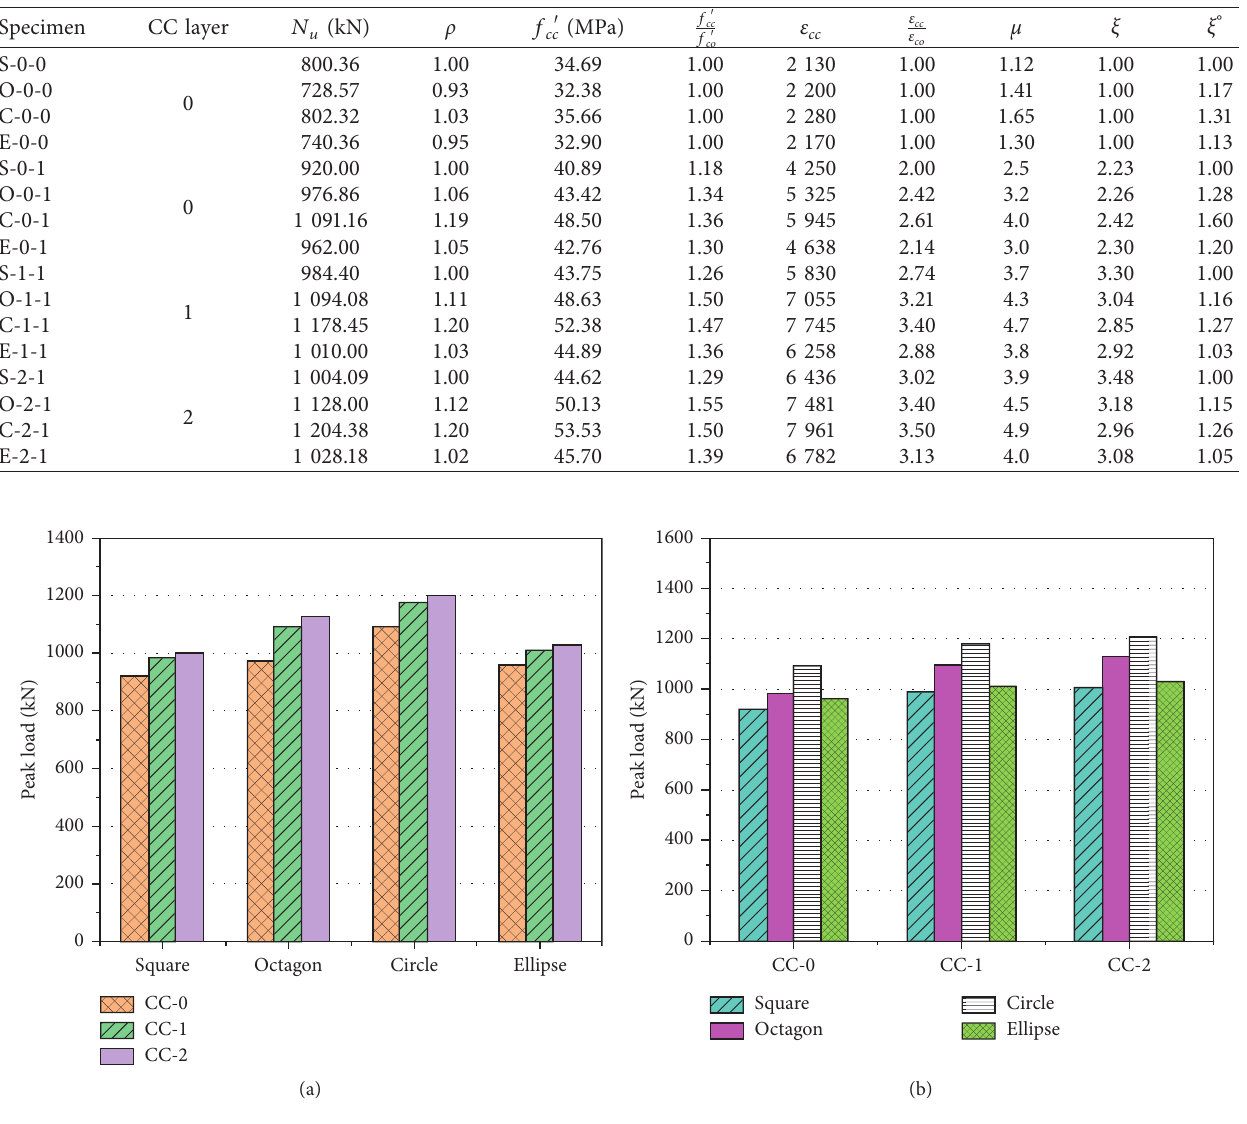
Table 6: Peak load and stress of each group of specimens.